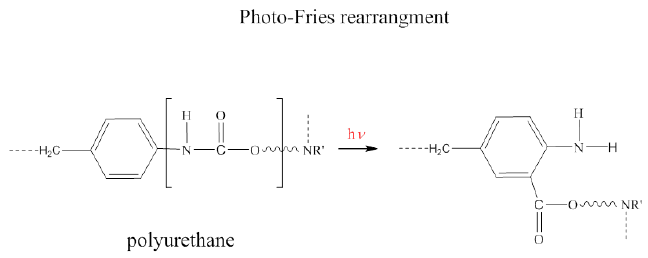
Figure 7. Photo-Fries rearrangement of polyurethane.